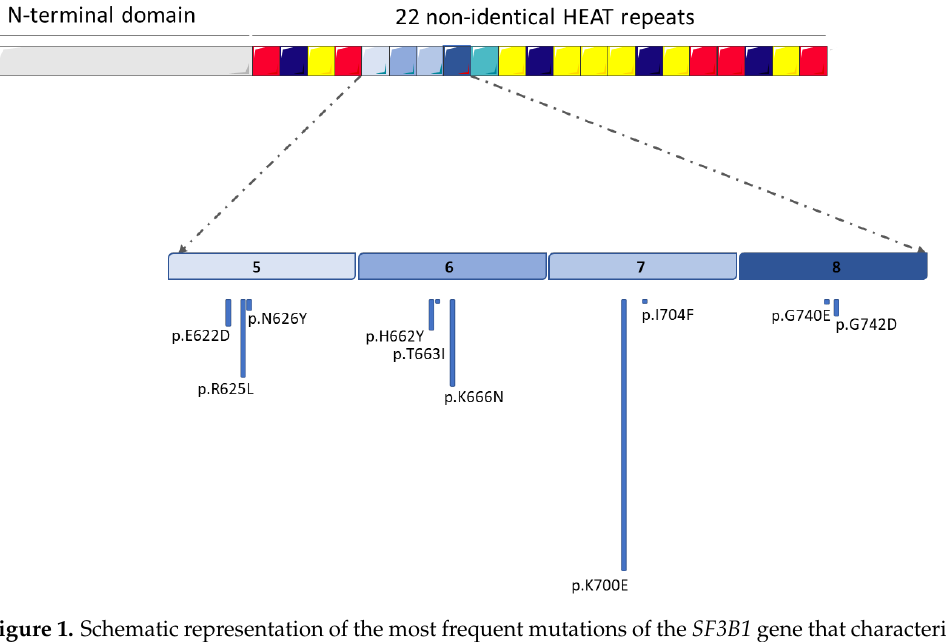
Figure 1. Schematic representation of the most frequent mutations of the SF3B1 gene that characterize hematological neoplasms. The numbers 5, 6, 7 an 8 in the figure correspond to the non-identical HEAT repeats most frequently affected by mutations. (the figure was modified from Servier Medical Art, licensed under a Creative Common Attribution 3.0 Generic License, http://smart.servier.com/, accessed on 17 August 2022).